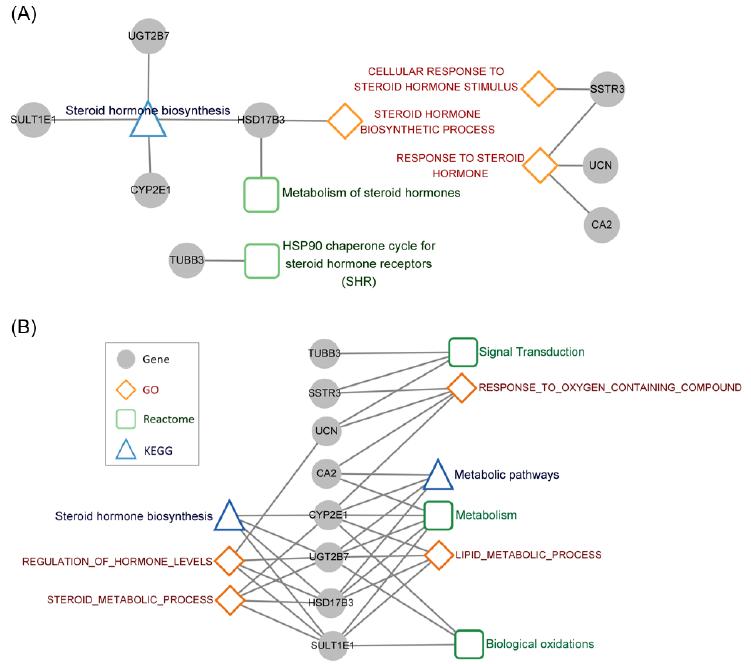
Figure 5. The regulatory pathways. Functional annotation of 8 genes based on three databases in aspects of ( A ) steroid hormone-specific and ( B ) all functions containing more than 3 of 8 signature genes. The gene is illustrated as a filled grey circle. Databases are drawn as an empty triangle, rectangle, and diamond. The grey edge represents linkage between annotated gene and the corresponding function.